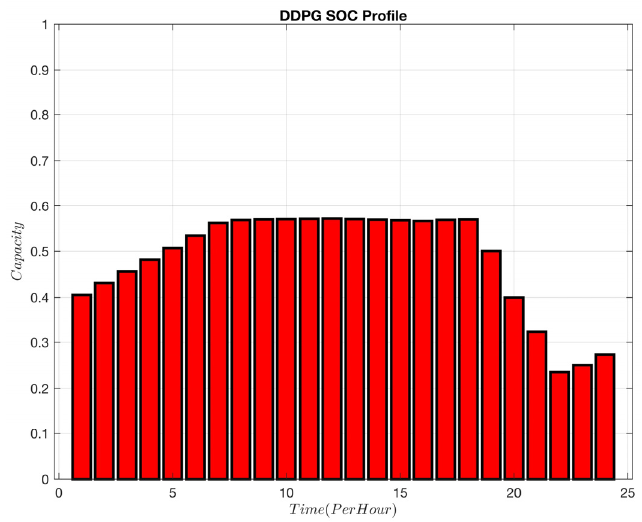
Figure 6. BESS SOC state of charge .